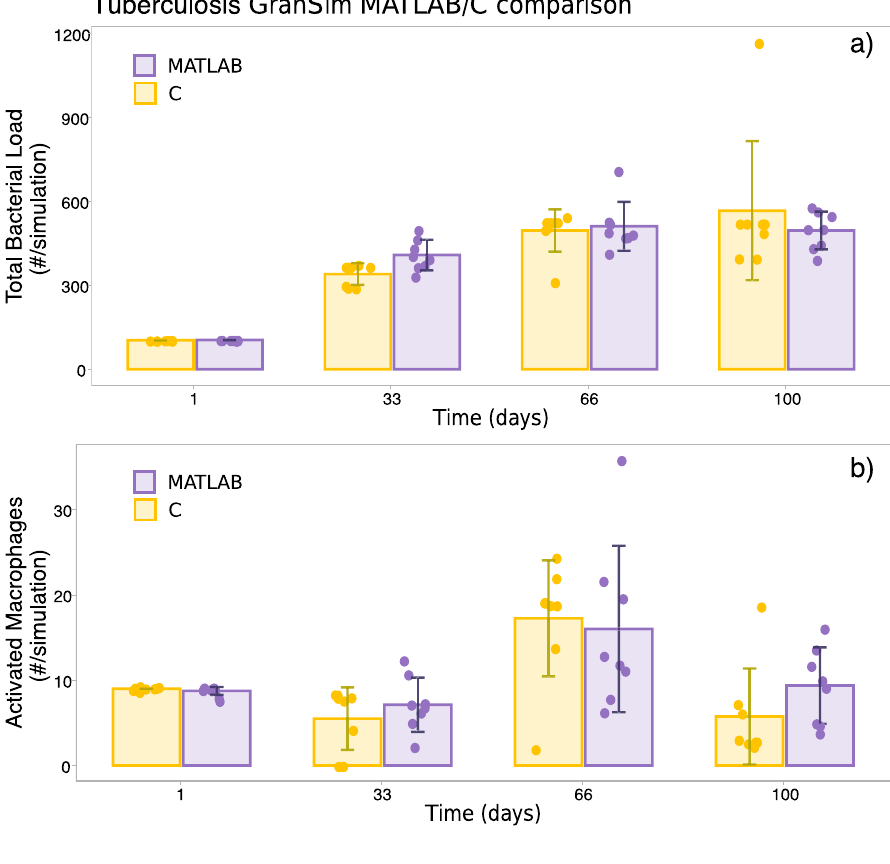
Fig. 4 Correctness of the tuberculosis GranSim model translation. The error bars represent the standard deviation of the average over fi ve simulation runs. a Total bacterial load and ( b ) number of activated macrophages at selected timepoints compared for MATLAB and QSPcc-generated C